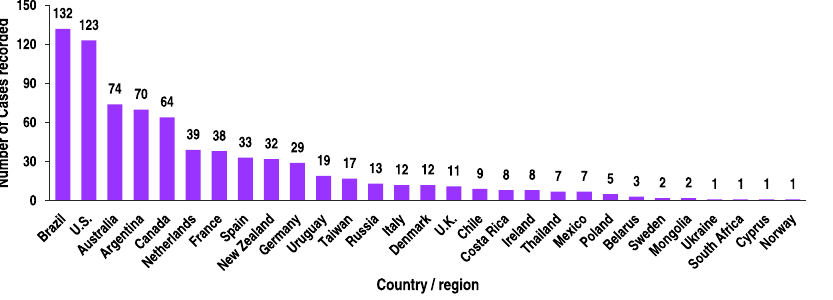
Fig. 2 Countries/regions of reported meat FF cases from imported food inspection noti fi cations. The columns indicate the total number of incidents in each country/region checked or reported as substandard based on the